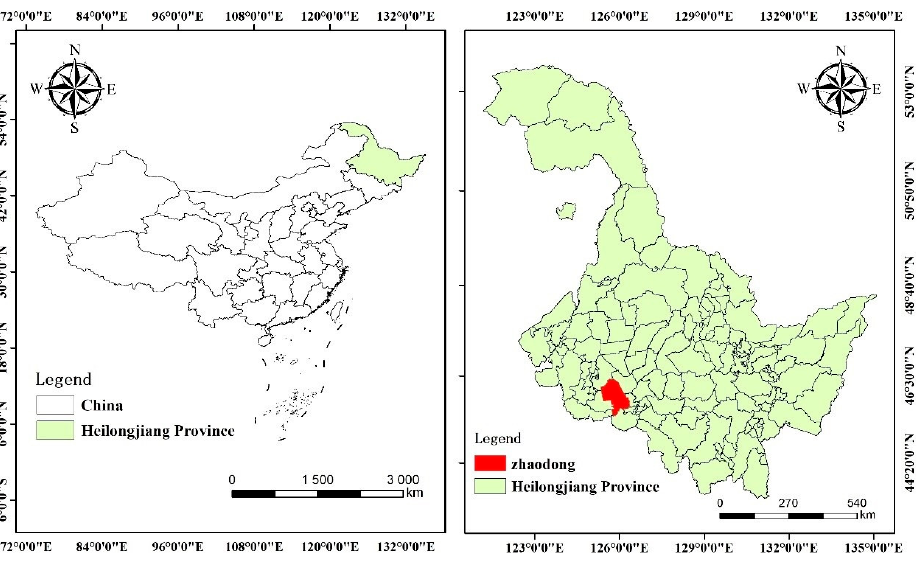
Figure 1. Overview of the study